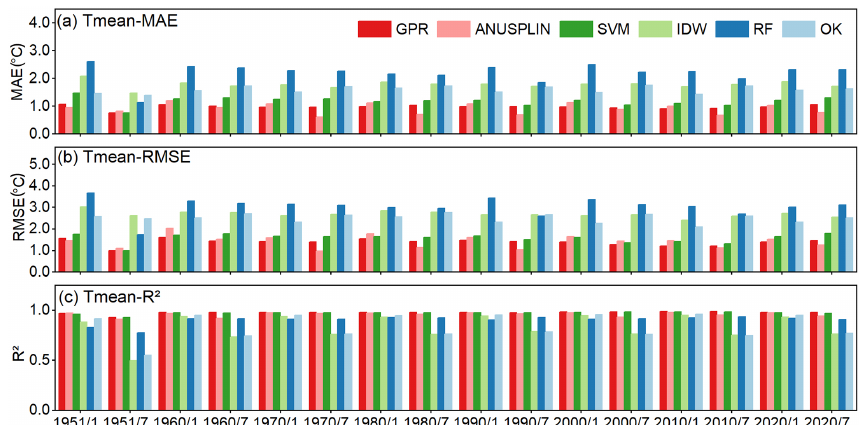
Figure 8. Accuracy of Tmean derived from the machine learning methods and traditional methods for January and July during 1951–2020 with an interval of 10 years.